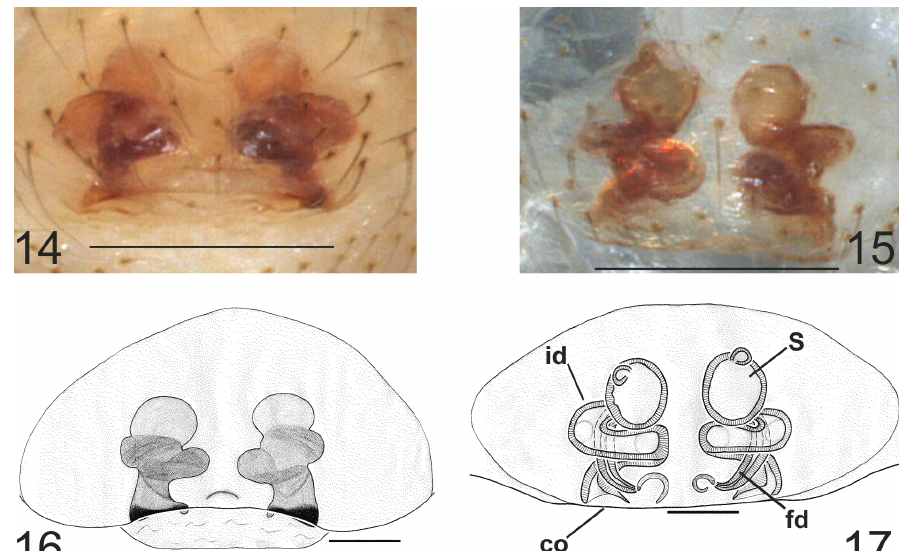
Figures 14–17. Typhlonesticus gocmeni sp. n. epigyne and vulva. 14 epigyne ventral view 15 vulva ven- tral view, 16 ditto 17 vulva dorsal view. Abbreviations: co = copulatory orifice, id = insemination duct, fd = fertilization duct, S = spermatheca. Scale bars 14–15 0.25 mm 16–17 0.1 mm.